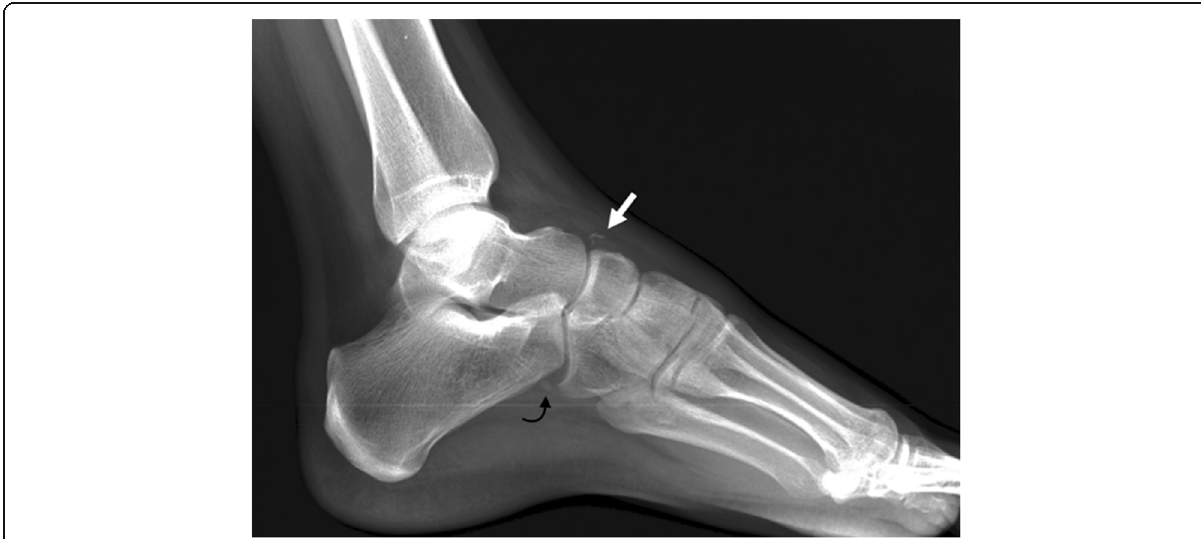
Fig. 7 Differential diagnosis of os supranaviculare. The differential diagnosis has to be established with an avulsion fracture of the talo navicular joint capsule, as seen in this lateral radiograph (white arrow). Note the mild swelling of the soft tissues associated and the more linear configuration of the fragment, compared to the more triangular shape of the ossicle. Incidental note os peroneum (curved black